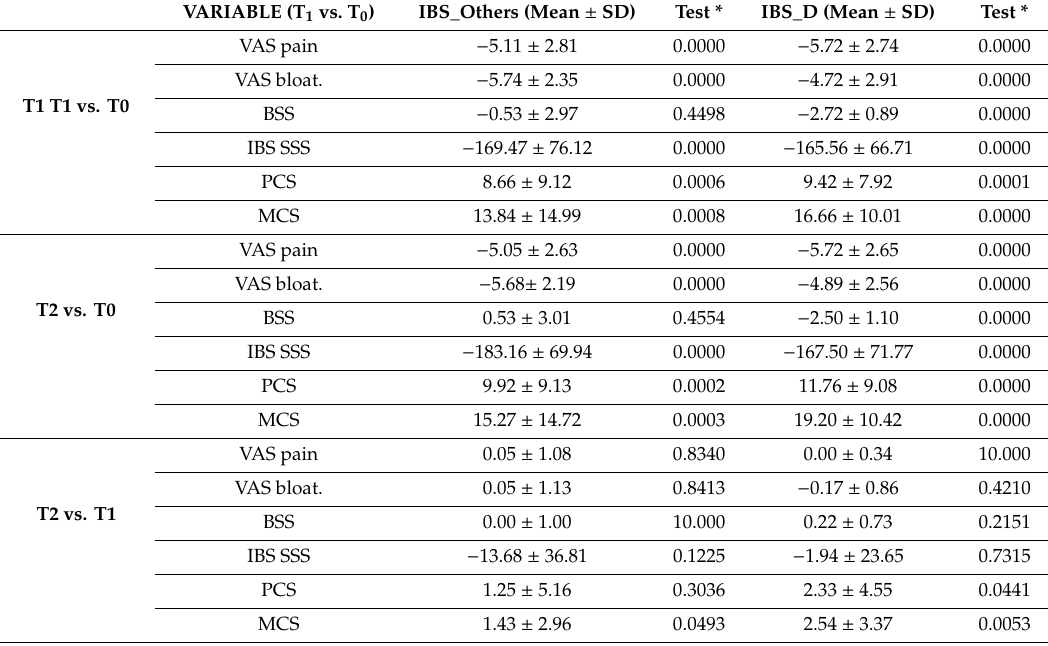
Table 4. Di ff erence in the mean values of scores between T0, T1, and T2. Score values: Visual Analogue Scale (VAS) bloating and VAS pain (0–10); Bristol stool chart (1–7); Irritable Bowel Syndrome Severity Scoring System (0–500); physical component summary and mental component summary side